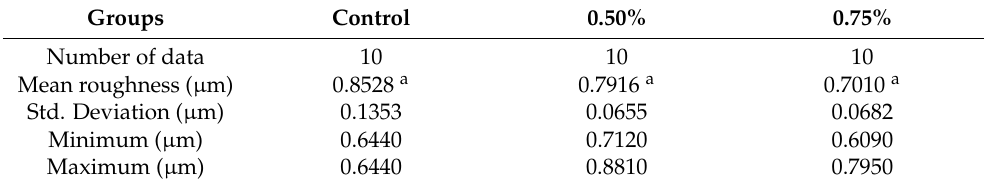
Table 4. Mean values of surface roughness in the CC resin incorporated with Ag-Zn zeolite at different concentrations (0.50 wt.% and 0.75 wt.%) and without any Ag-Zn zeolite (control group). Different superscript letters represent statistically significant differences ( p <